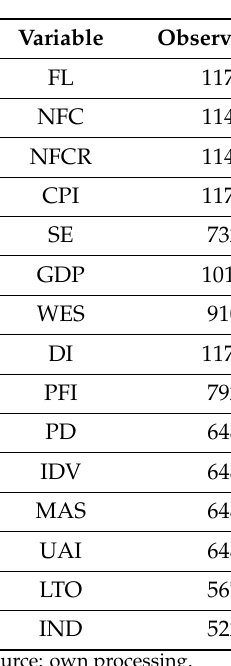
Table 3. Summary